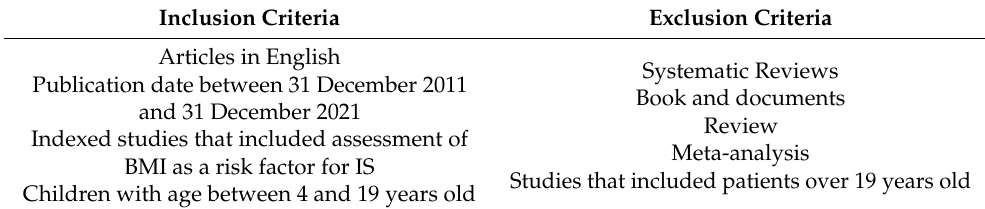
Table 1. Eligibility